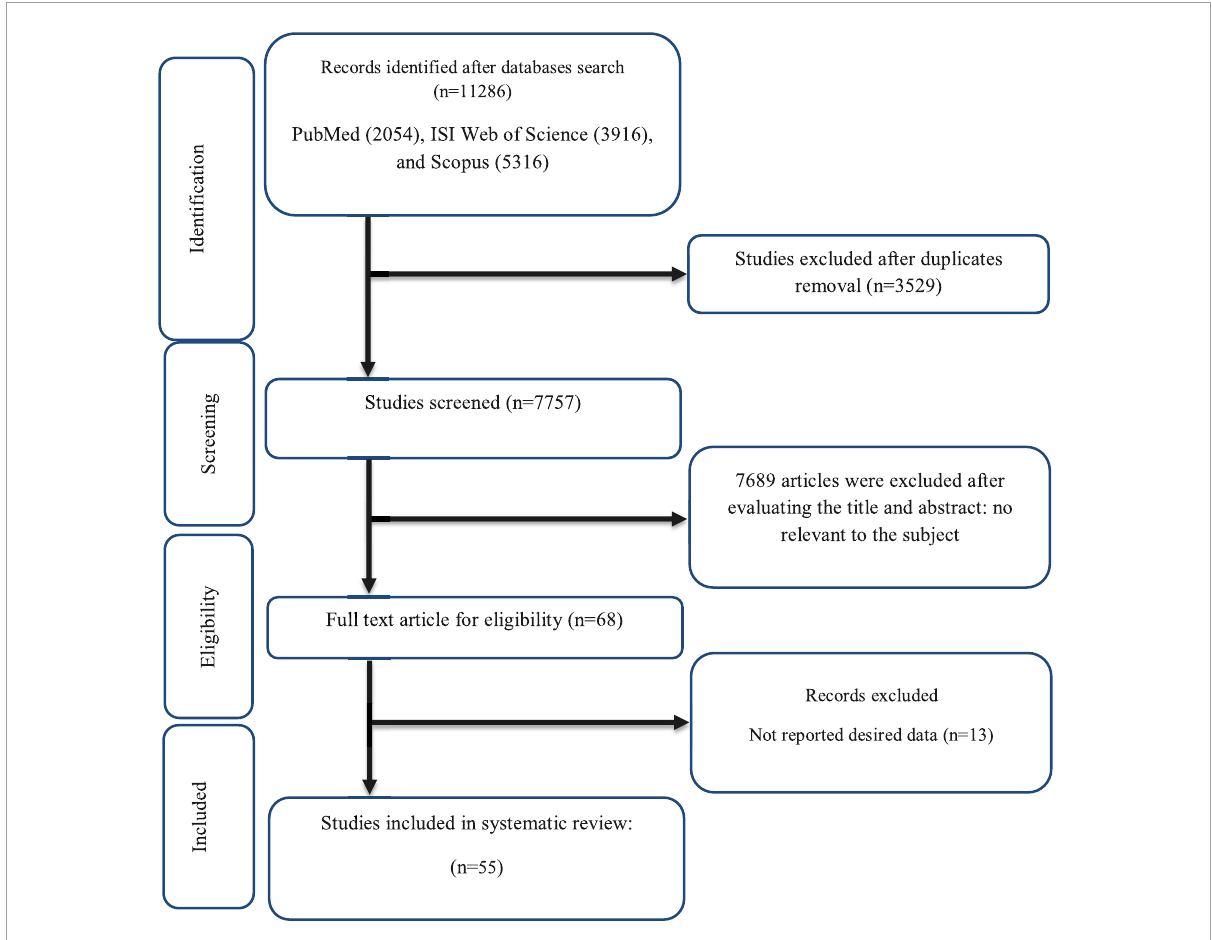
FIGURE1 Flow chart of study selection for inclusion trials in the systematic